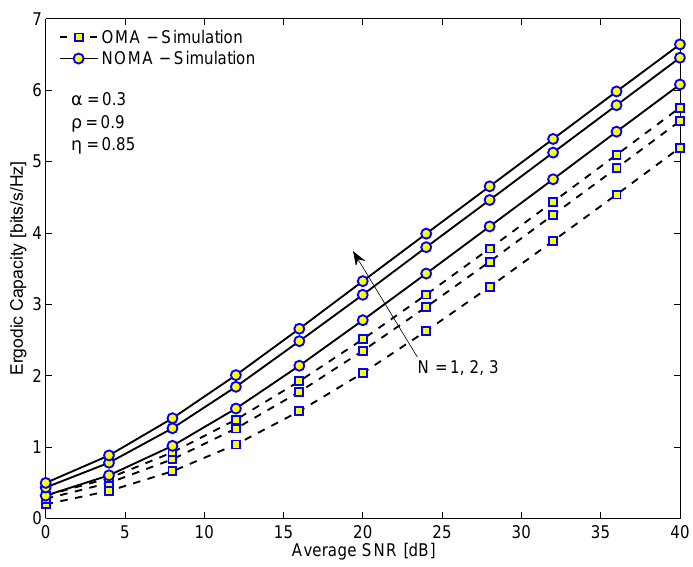
Figure 8. The comparison of the ergodic capacities of the EH-NOMA relaying system and the EH-OMA relaying system versus the average SINR for different numbers of